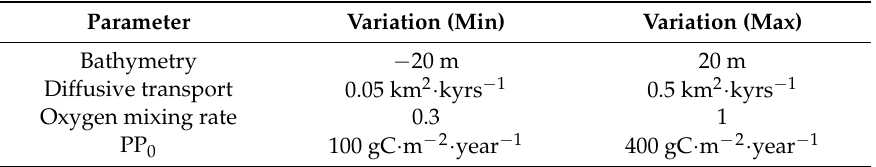
Table 1. Range of variations of critical parameters tested in the study. Bathymetry: The range of variation ( ± 20 m) is ± 13% of the estimated maximum paleobathymetry (~150 m). Diffusive transport: It ranges from sand (0.5 km 2 · kyrs − 1 ) to clay (0.05 km 2 · kyrs − 1 ) particle behavior in order to simulate organo-mineral agglomerates [42]. Oxygen mixing rate: The variations (formulated by values without dimension) vary from a confined environment (0.3) to an open and agitated environment (1). PP0: The primary productivity (in gC · m − 2 · an − 1 ) along the coastline, this values decrease with a seaward decrease of 5% of the initial value every 10